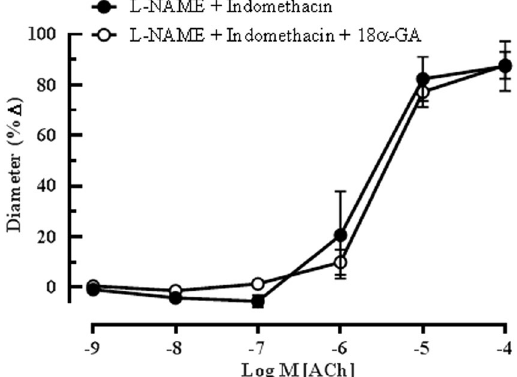
Figure 5. Effect of 18 α -GA on EDHF-mediated relaxation of the ophthalmic artery from eNOS − / − mice to ACh. Incubation of the vessels with 18 α -GA evoked no inhibitory effects on vasodilation, indicating null involvement of gap junctions in mediating EDHF-type responses in the ophthalmic artery. Values are expressed as mean ± s.e.m (n = 6 per group).